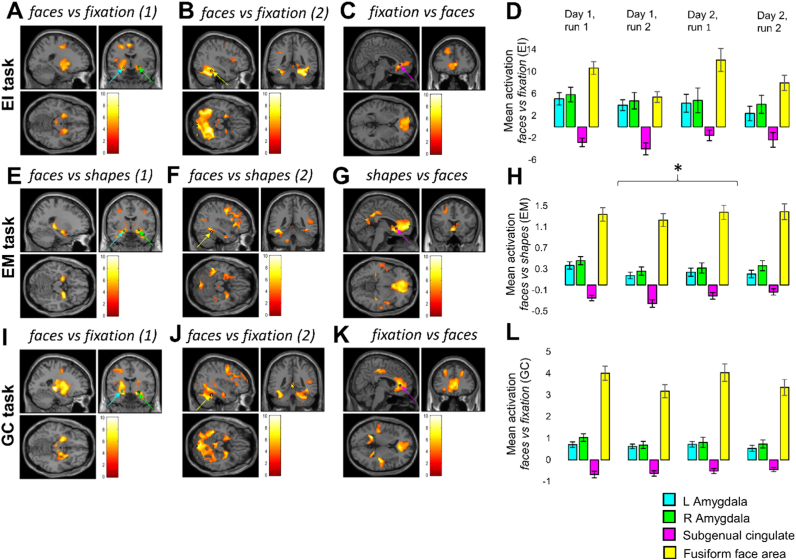
Whole-brain activation maps and parameter estimates for the three functionally-defined regions of interest (left and right amygdala, and subgenual anterior cingulate cortex, sgACC), and the comparison region, the right fusiform face area (FFA), for all runs (both days). Coloured arrows and stars indicate coordinates used in the analysis: cyan arrows correspond to peak activation in the left amygdala; green arrows to peak activation in the right; yellow arrows indicate the coordinate from a previous study (McKeeff and Tong, 2007) used for the FFA analysis; magenta arrows indicate peak activation in the sgACC. Images were thresholded at p<0.001 (uncorrected) and at the minimum cluster size surviving whole-brain cluster-level correction for each contrast; the heat bars indicate t-values. Please see Table 2 for statistics. A, E, I: faces vs fixation (1) and faces vs shapes (1) include all subjects; faces vs fixation (2) and faces vs shapes (2) (B, F, J) exclude the four subjects whose FFA was not included in the mask. Asterisk over the EM (*) bar chart depicts the only main or interaction effect of day or run: the effect of day on sgACC activation (p=0.045).